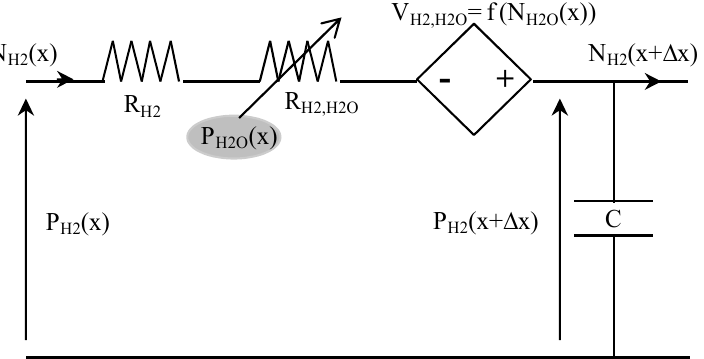
Figure 4. Equivalent electrical circuit for hydrogen transport in anode